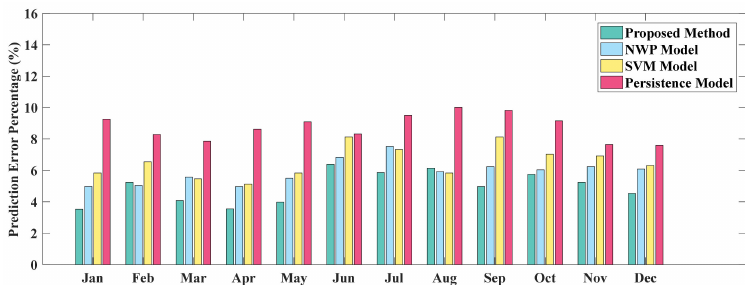
Figure 17. Monthly nMAE percentage comparison of each regional forecast